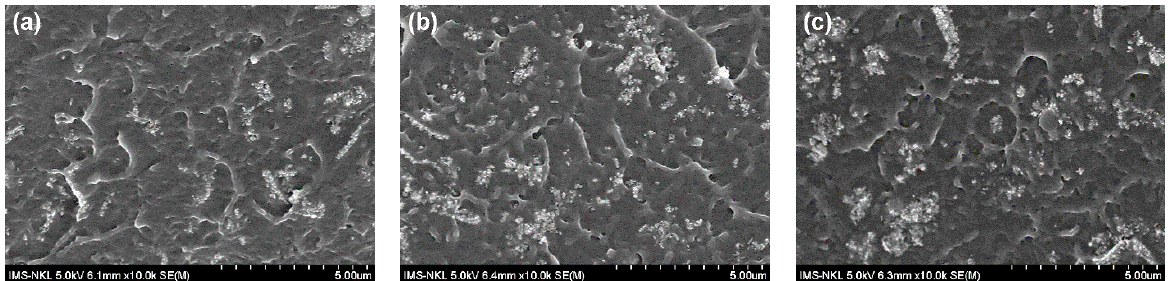
Figure 8. FESEM images of fractured cross-section of gHAP-BC group at different loadings of gHAP ( a ): 5 wt.%, ( b ): 10 wt.% and ( c ): 15 wt.%.